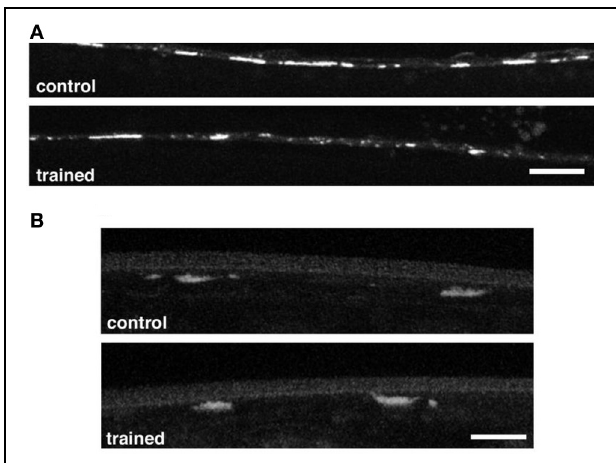
FIGURE 4 | (A) Representative images of GLR-1::GFP expression in interneurons of the posterior ventral nerve cord in a worm that had been given spaced training for long-term memory for habituation 24h before and an untrained control worm. There were significantly smaller GFP clusters in the trained worms than in the control worms. (B) Representative images of the vesicles in tap sensory neuron terminals visualized with a synaptobrevin GFP marker in control and trained worms. There was no difference in measured GFP expression between the trained and control worms (Rose et al.,